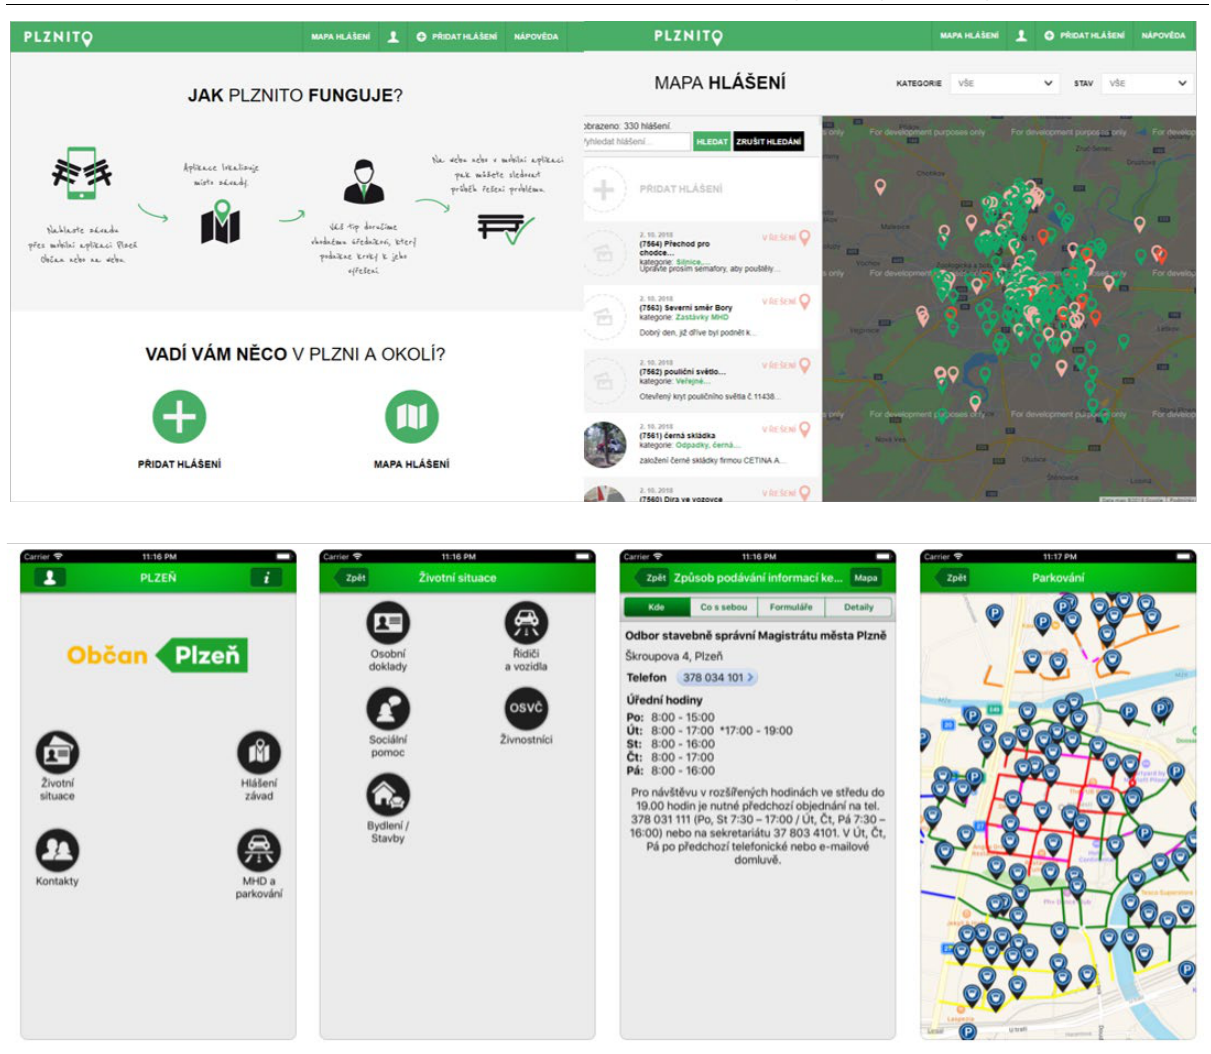
Figure 3. Two channels for citizen reporting in Plzeň (webGIS and mobile app)